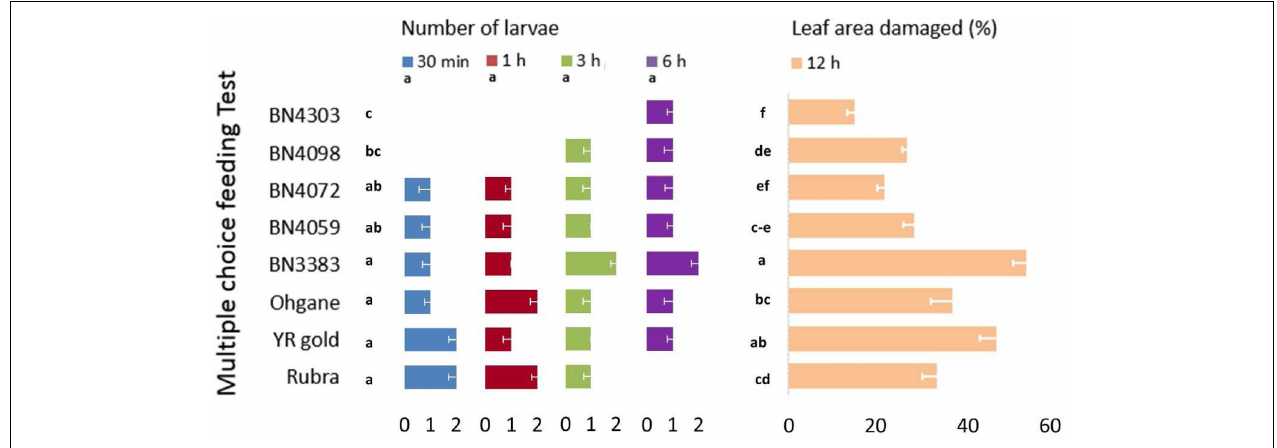
FIGURE 5 | Genotypic variation in eight cabbage genotypes in terms of feeding preference and extent of leaf damage by DBM larvae as determined by in vitro multiple-choice feeding test. Data recorded at different time points and presented as mean ( n = 8). The error bars indicate standard deviations. Different letters across genotypes and time-points indicate statistically significant differences for number of larvae and percent leaf area damaged over all time points and genotypes, respectively, as per Tukey’s pairwise comparisons.